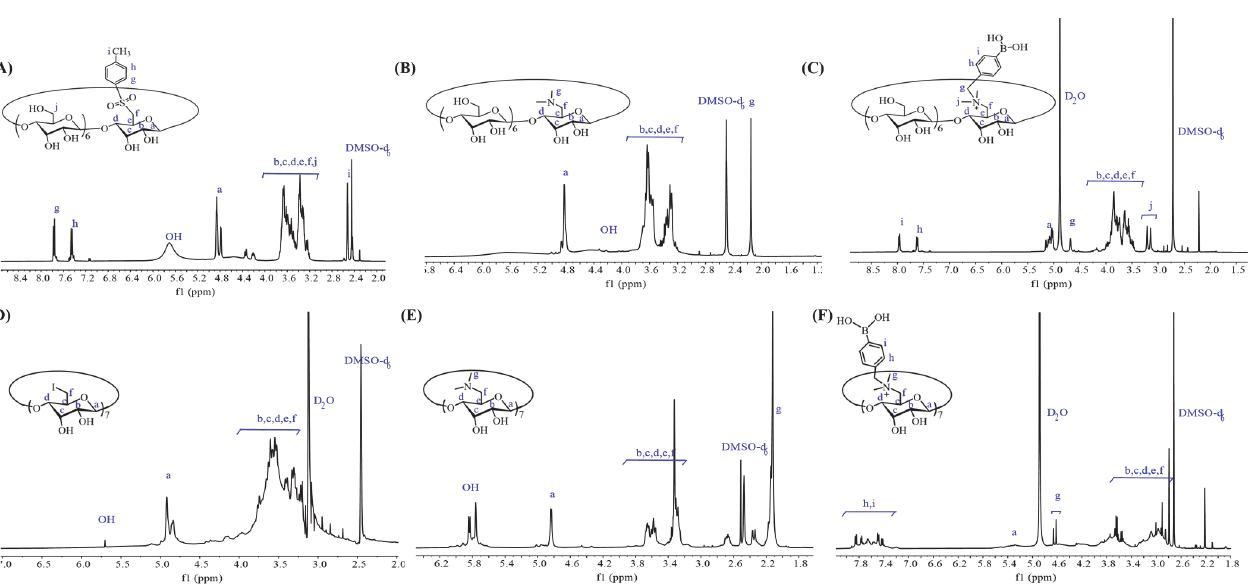
Figure 2. 1 H NMR spectra for ( A ) CD ‐ OTs, ( B ) CD ‐ (dma) 1 , ( C ) CD ‐ QAS ‐ B 1 , ( D ) CD ‐ I 7 , ( E ) CD ‐ (dma) 7 , ( F ) CD ‐ QAS ‐ B 7 .